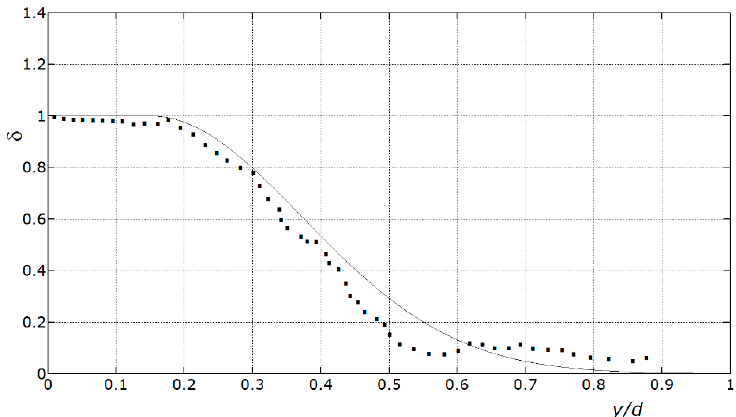
Figure 6. Comparison between the results from the proposed formula and the results from the non-linear analysis. Solid line: δ obtained from Equation (15). Points: values of δ to plug into Equations (16)–(19) in order to obtain the ultimate load provided by the non-linear analysis.